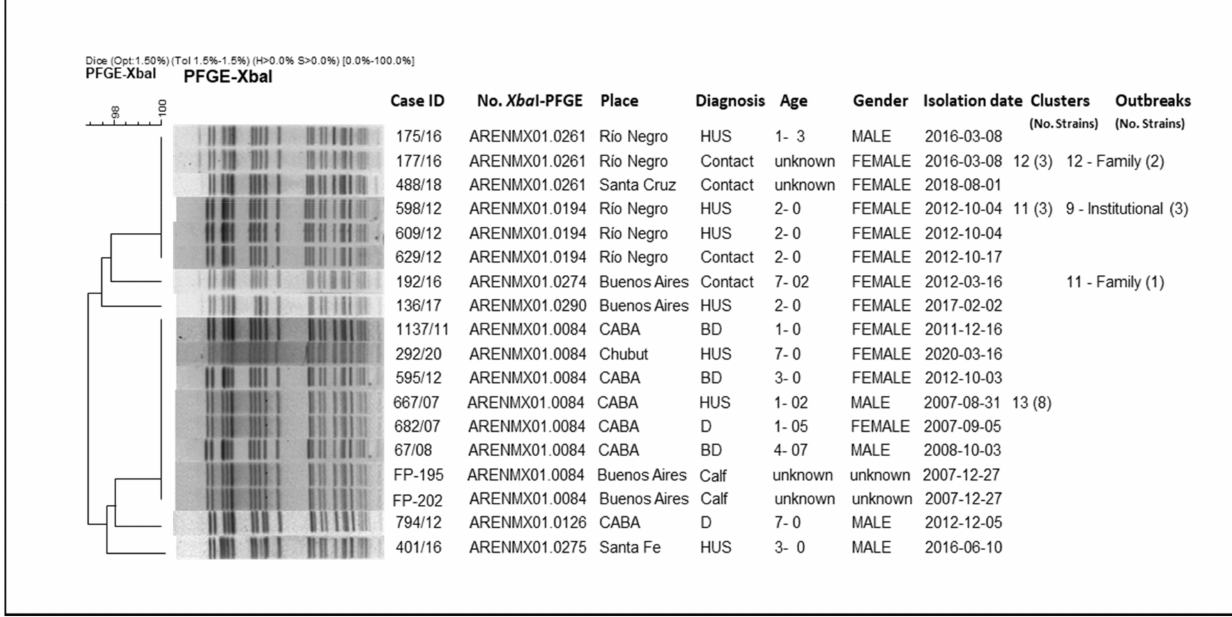
Figure 4. Clonal relatedness of different STEC O145 including one cluster with human and bovine origin strains, by Xba I-PFGE.